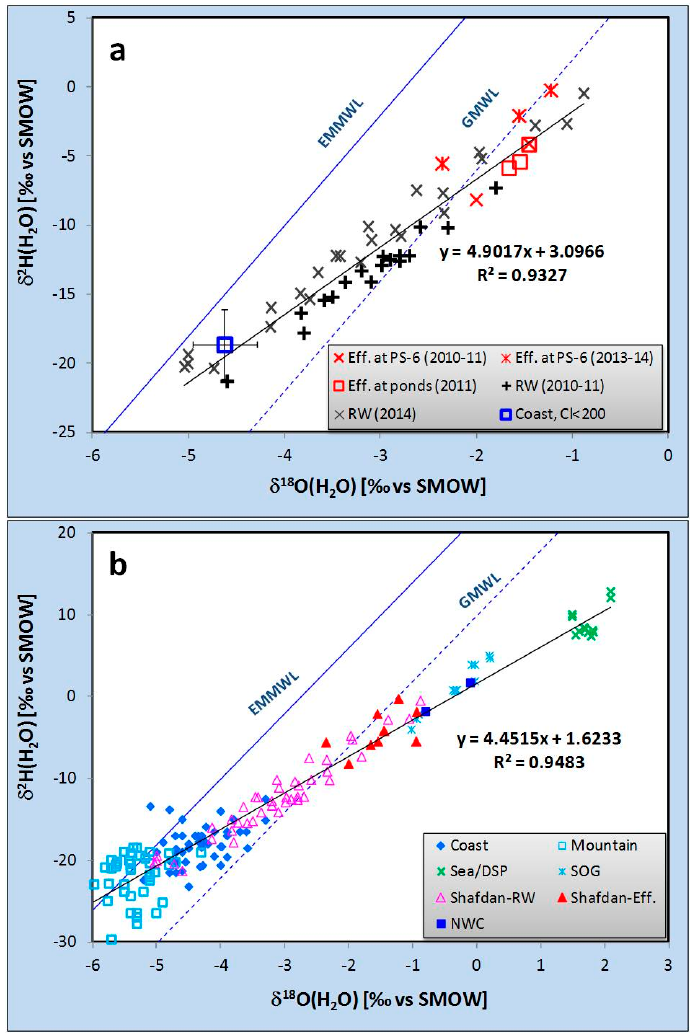
Figure 3. Water molecule isotopic compositions: ( a ) the Shafdan system, including the recharged effluents (PS ‐ 6 or at the ponds) and the recovery wells (RW); and ( b ) the freshwater sources, in the National Water Carrier (NWC) and in the Shafdan system. Isotope data for the Coastal Aquifer, Mountain Aquifer, Mediterranean Sea, desalinated water (DSP), and for the Sea of Galilee (SOG) were taken from previous works [3,5,8,29–35].